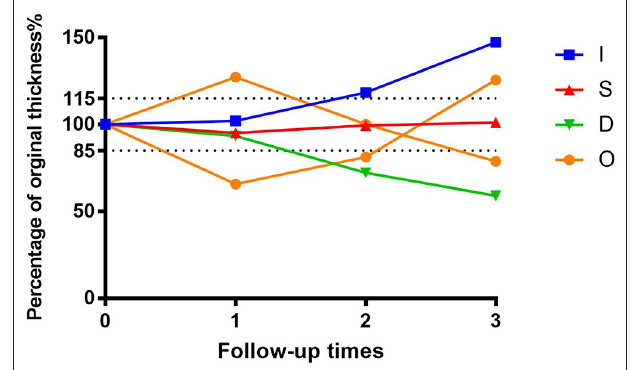
FIGURE 6 | Percentage graph of initial tumor thickness vs. duration of follow-up after iodine 125 brachytherapy for patients with uveal melanoma by tumor regression patterns (D vs. S vs. I vs. O).